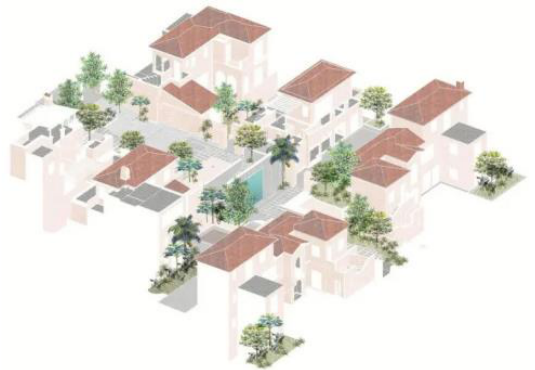
Figure 4. Landscape distribution of Sanya Anaya community .